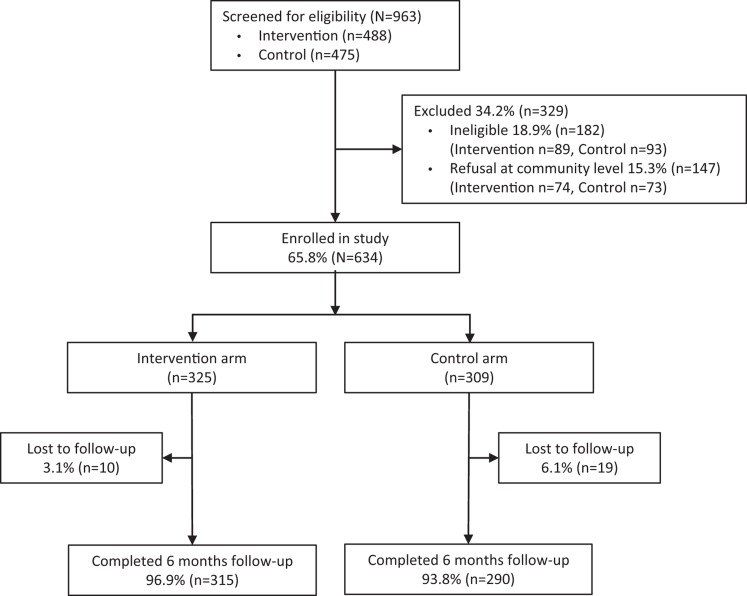
Flow Diagram of Progress of HIV-Infected Study Participants Through the Study